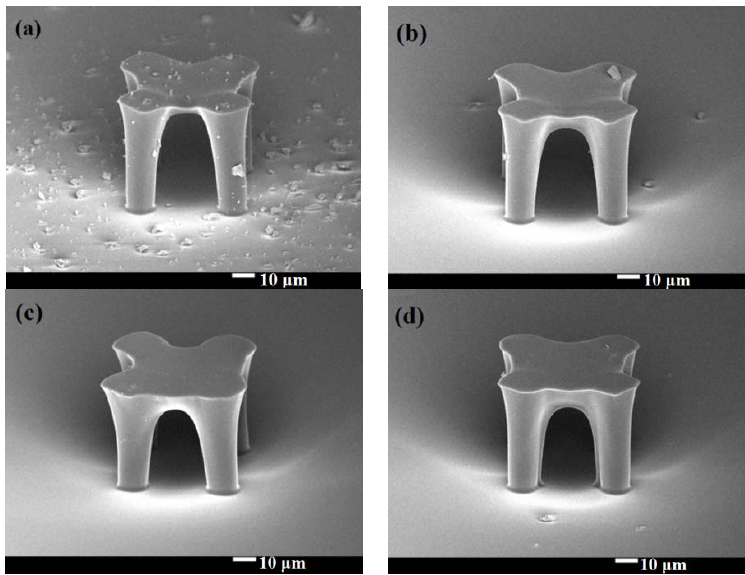
Figure 4. SEM pictures of different stable platforms.